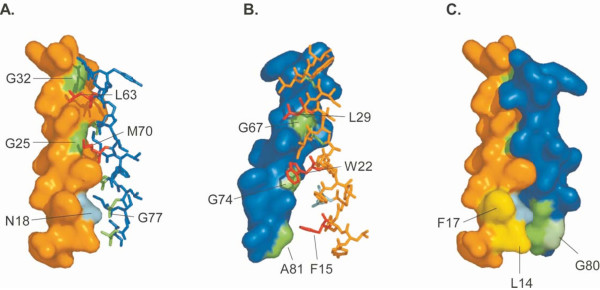
Structural model of TM1-TM2 interaction in CD9. Shown are space-filling models of CD9 TM1 (panel A), TM2 (panel B), and the two helices together (panel C). Small and large residues of heptad positions a and d, which form the crucial contacts between the helices, are shown in green and red, respectively. Asn18 is shown in blue, Leu14 and Phe17 in yellow, and Gly80 in light green.